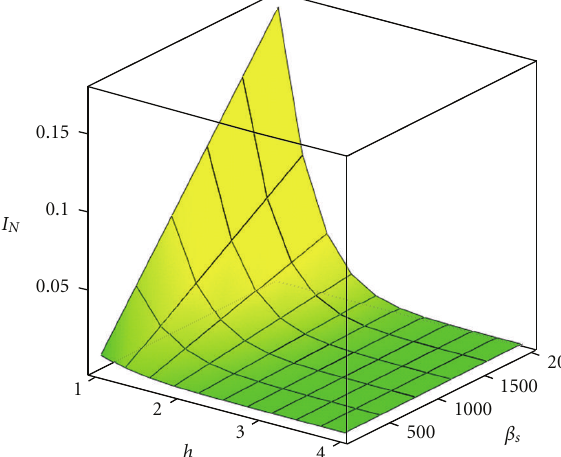
Figure 7: I N ( h , β s ) for w c = 0 . 04 ( ψ = 5), Elastic-Plastic Range